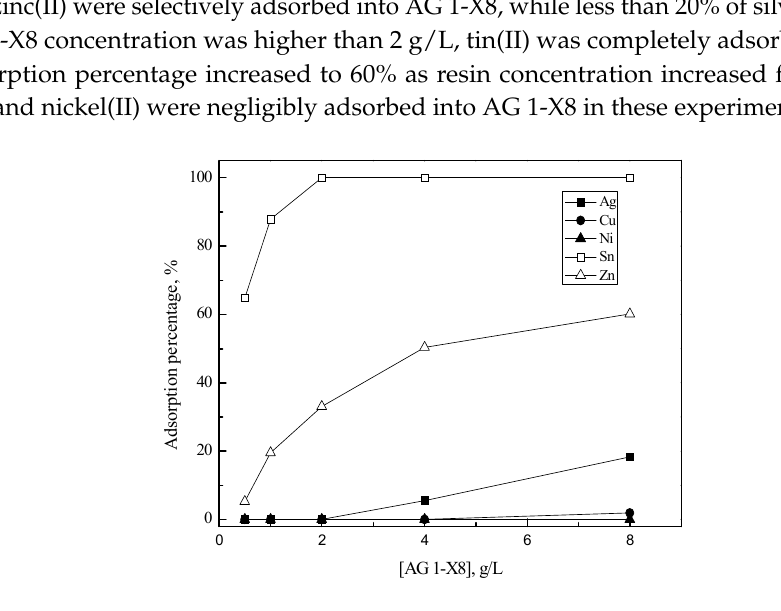
Figure 1. Effect of AG 1-X8 concentration on the adsorption of metals in 5 M HCl solution. [AG 1-X8] = 0.5–8 (g/L), time = 6 h, shaking speed = 200 rpm.